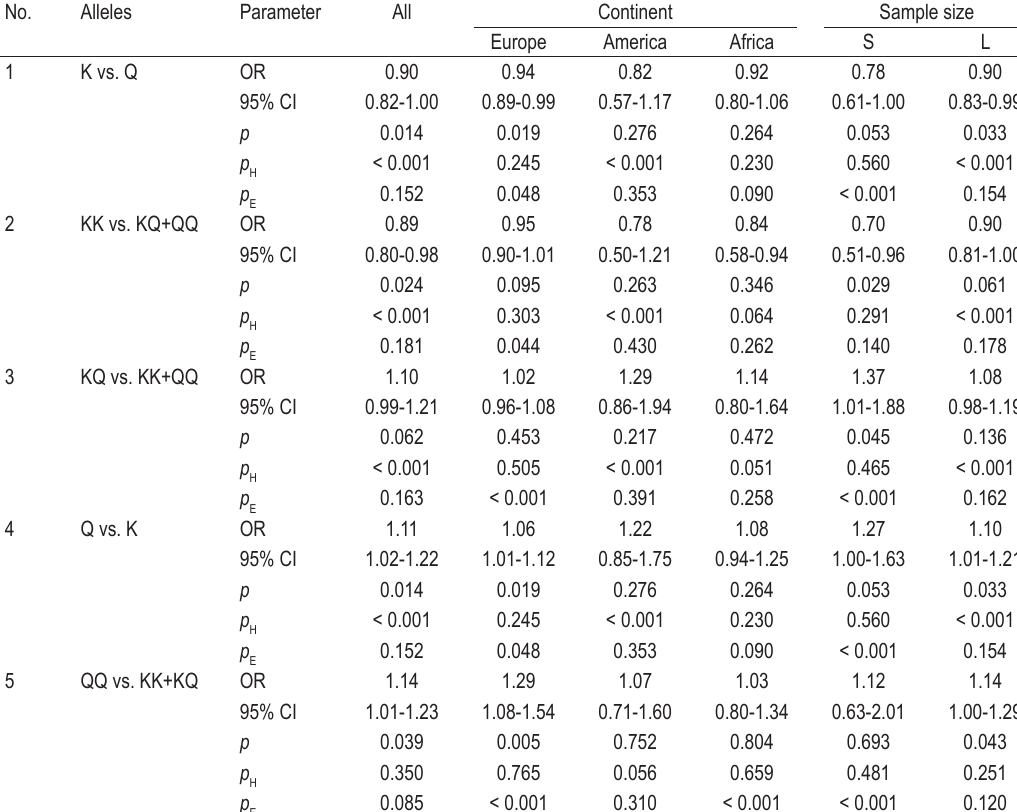
TABLE 2. Summary ORs and 95% CIs of the association between the ENPP1 K121Q gene polymorphism and the risk of T2DM No. Alleles Parameter All K vs.